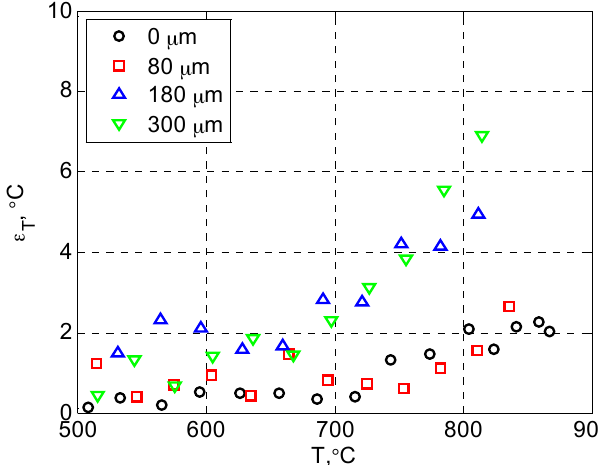
Figure 7. Calibration uncertainty of Dy-doped TBC with different topcoat thickness.